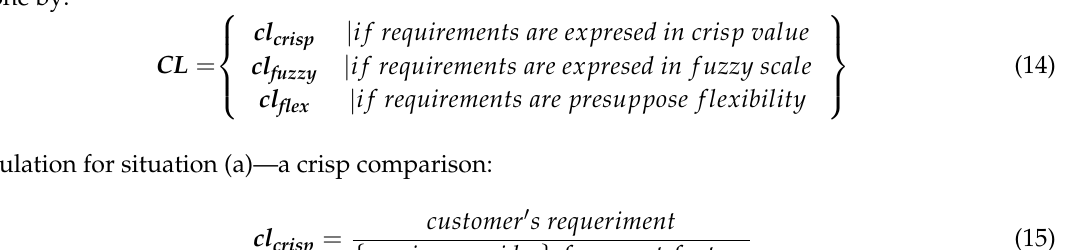
Table 7. Provider flexibility scale. Flexibility Degree